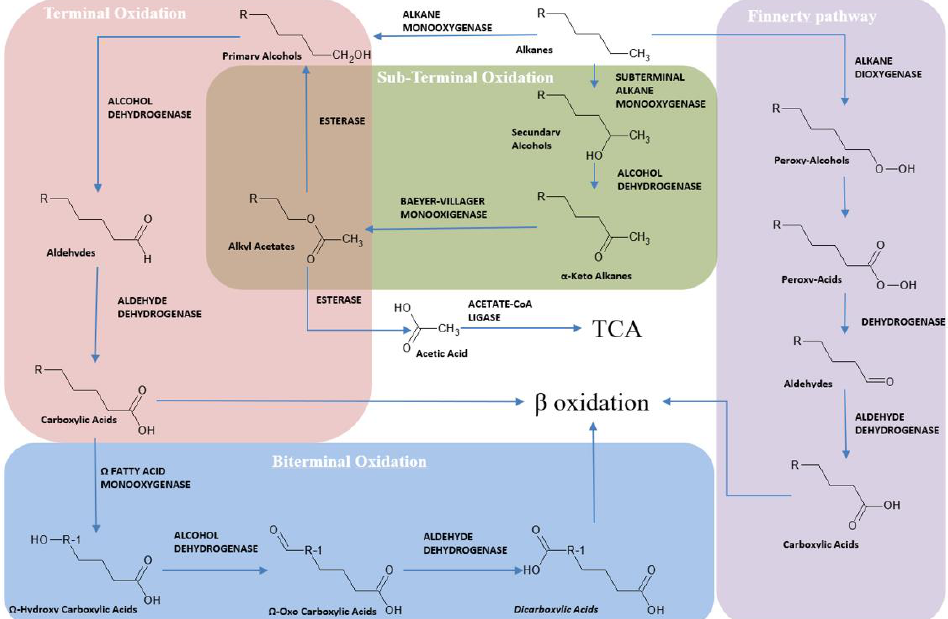
Figure 2. Possible branches of the aerobic degradation of n -alkanes. A bifurcation is possible at the end of terminal oxidation pathway: the obtained carboxylic acid can ether go through β -oxidation or be further oxidized by the ω -fatty acid mono-oxygenases to form dicarboxylic acid (biterminal oxidation). The products of Subterminal oxidation pathway are secondary alcohols or methyl acetone, which can be further oxidized by Baeyer–Villiger mono-oxygenases and esterases to generate fatty acids and primary alcohols. The first step of Finnerty pathway is the formation of n-alkyl hydroperoxides by alkane dioxygenases that are oxidated to fatty acids.